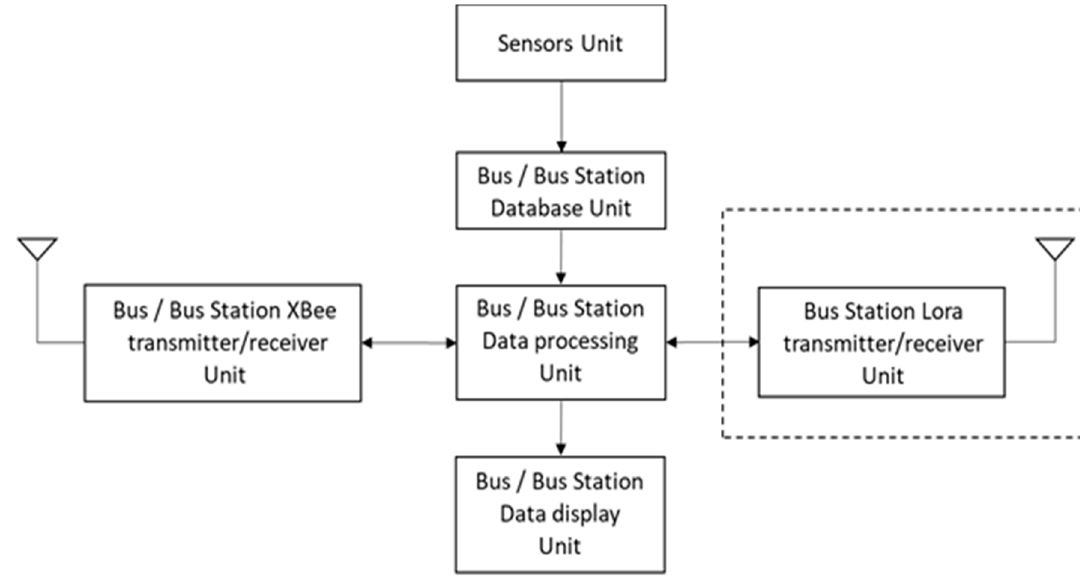
Figure 4. Framework on the bus and the bus station, where the bus station is with the dotted box.